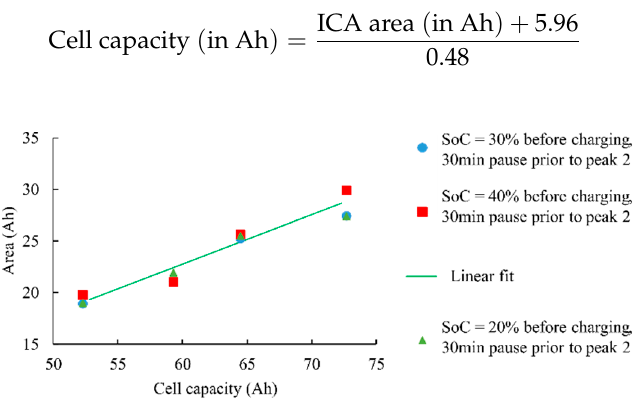
Figure 8. Measured area function of cell capacity for various DoD and with pause before peak 2 (C/3- 25 °C).